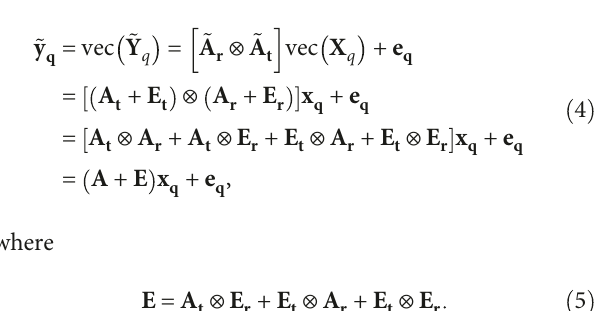
Figure 1: Bistatic MIMO radar con fi